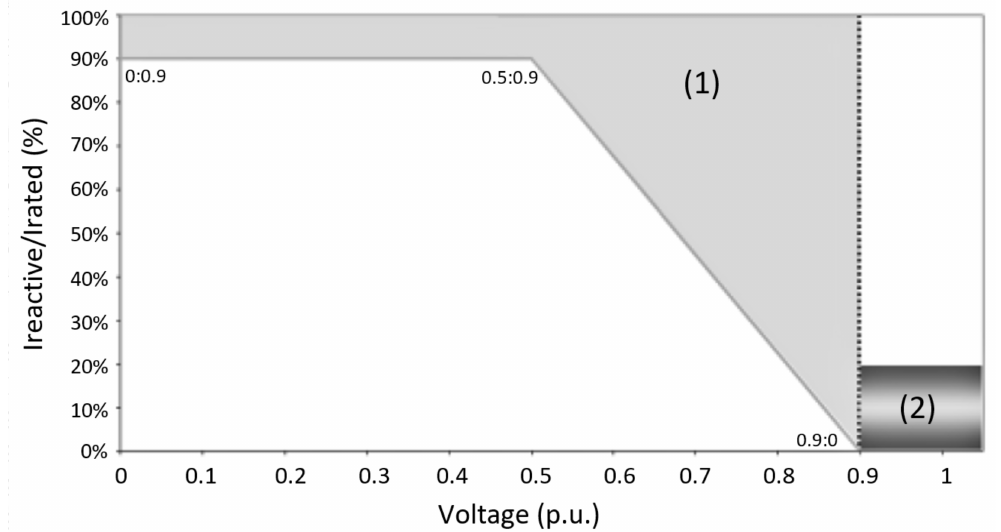
Figure 2. Grid support during faults by reactive current injection as specified in the Portuguese grid codes